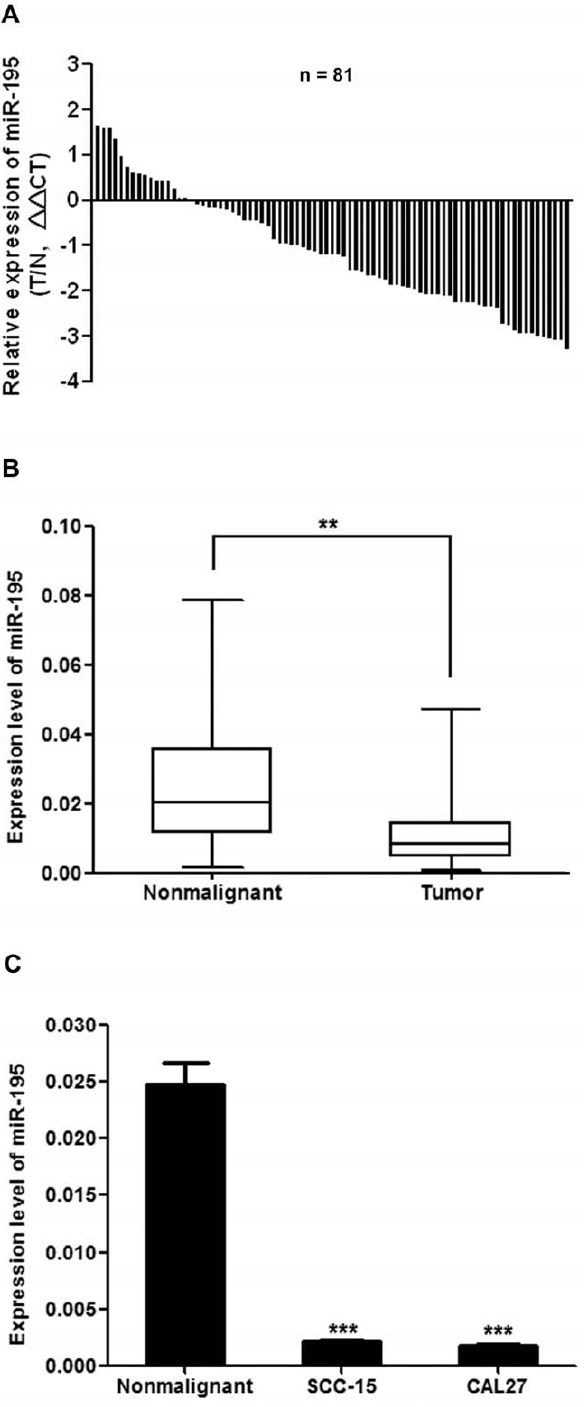
Figure 1. miR-195 expression was reduced in human TSCC and cell lines. (A), Relative levels of miR-195 in 81 surgical specimens of TSCC and matched adjacent nonmalignant tissues was quantified by qRT-PCR. Data were presented as log2 fold change ( DD CT values, TSCC/ Nonmalignant, T/N). (B), Means of miR-195 relative levels for 81 surgical specimens of TSCC and the matched adjacent nonmalignant tissues. Data were presented as 2 2 D Ct (miR-195-U6) values (** P , 0.01). (C), miR-195 expression was examined by qRT–PCR for 81 surgical specimens of nonmalignant tissues and cell lines as indicated. Data were presented as 2 2 D Ct (miR-195-U6) values (*** P , 0.001).